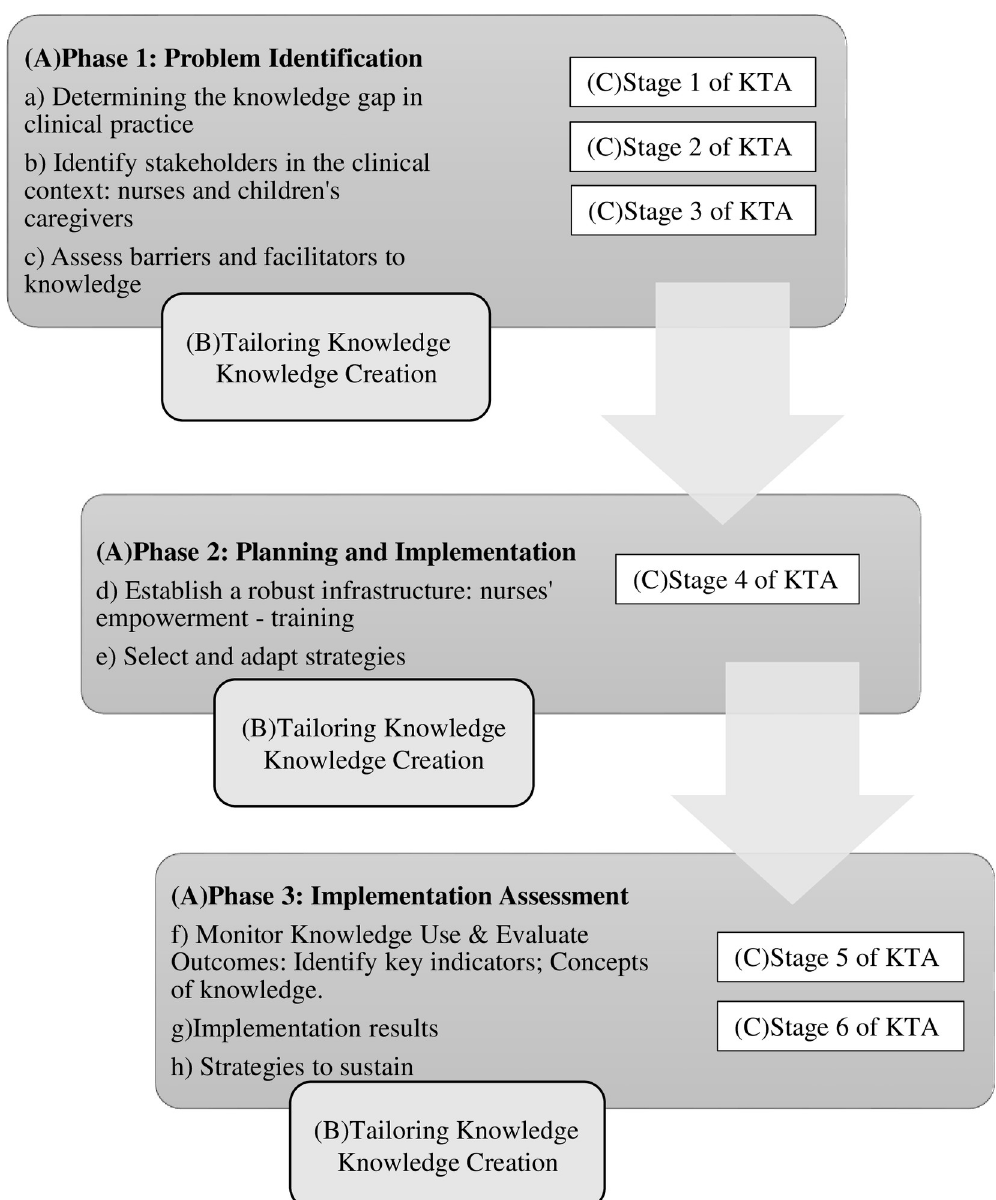
Fig 1. KTA framework and structure of the research project [8, 12, 13]. (A) Phases of research. (B) Creation of Knowledge, KTA. (C) Stages of the Action Cycle,